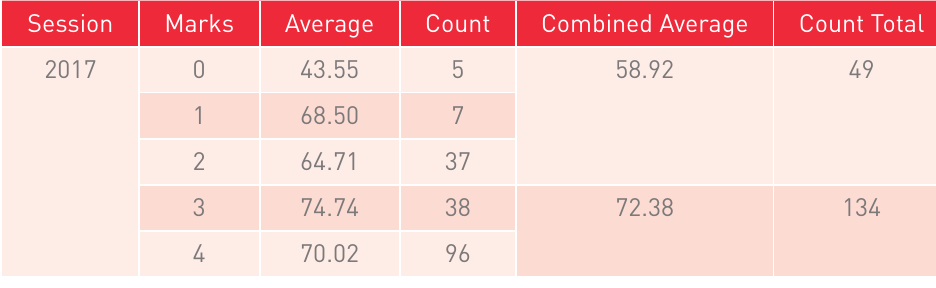
Students sketch marks for 2017 and